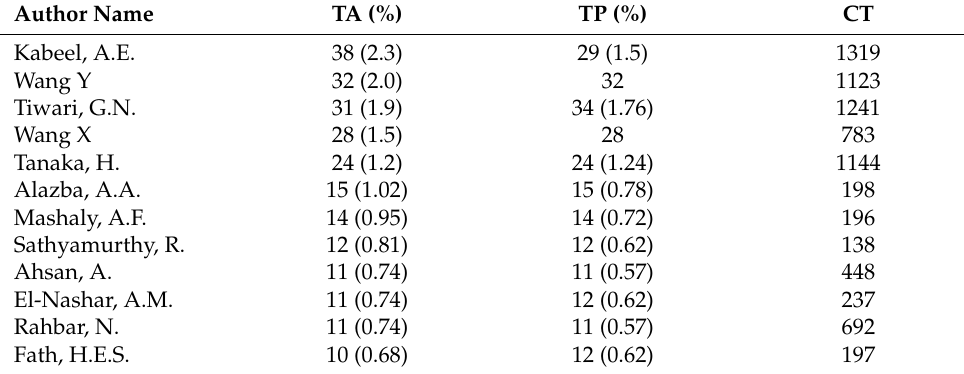
Table 6. The 10 most contributing authors.